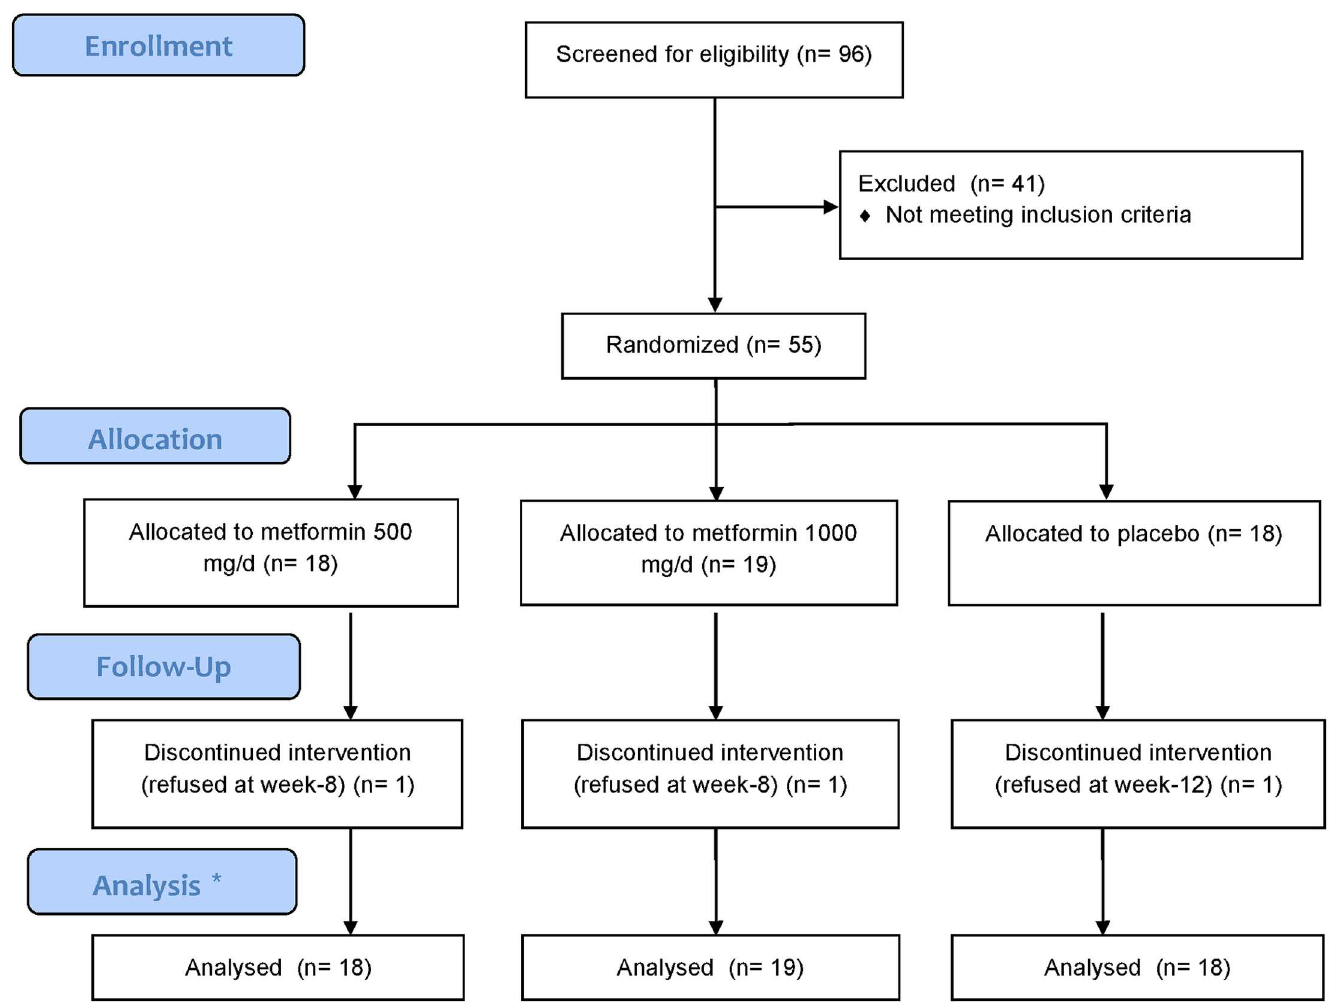
Fig 1. Flowchart of recruitment process—Weadopted the LOCF approach. Patients who continuedthe intervention for at least 4 weeks were includedin the analyses.